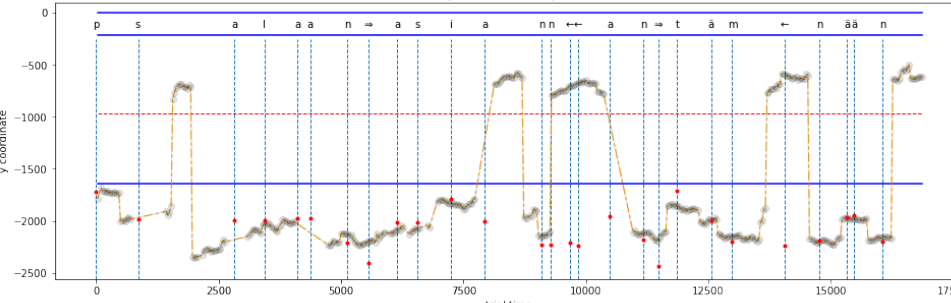
Figure 7. Example of a user’s typing and vertical gaze position timeline. The vertical bounds of the keyboard and text editing area are marked with blue lines. The threshold for classifying upwards gazes is shown with the orange dotted